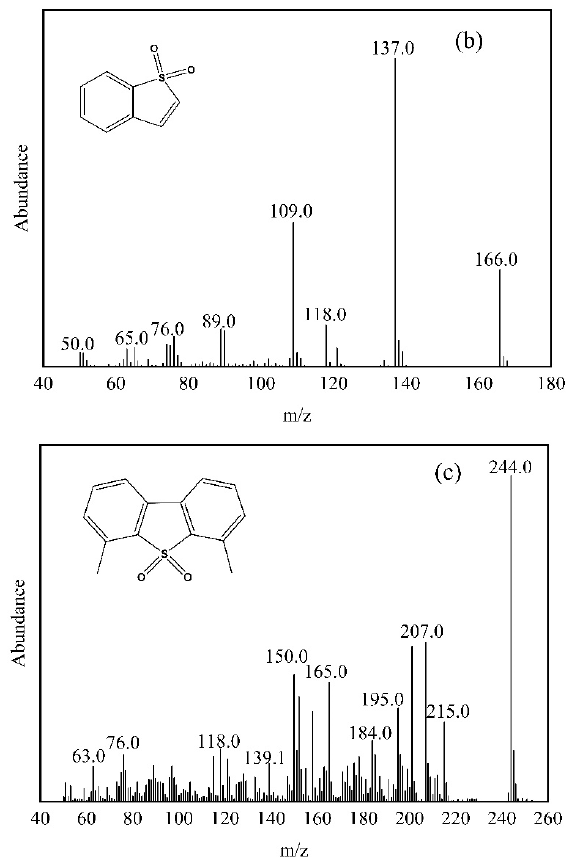
Figure 9. ( a ), ( b ) and ( c ) MS spectra of the oxidized products of DBT, BT, and 4,6 ‐ DMDBT.